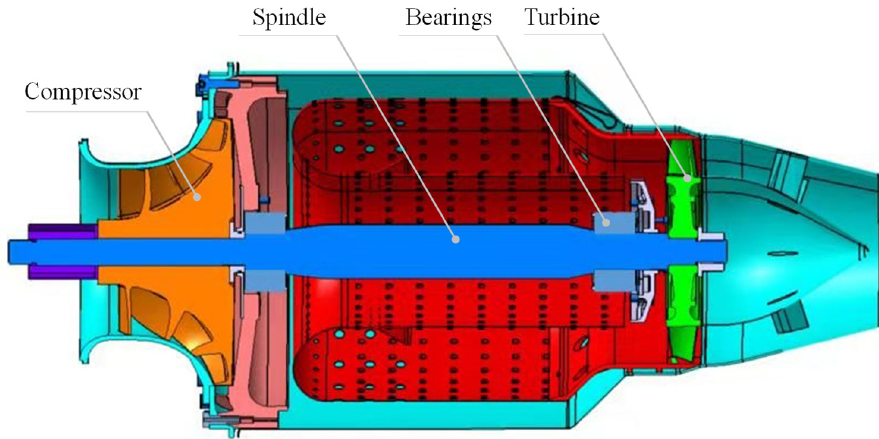
Figure 1. A schematic diagram of a turbojet engine.